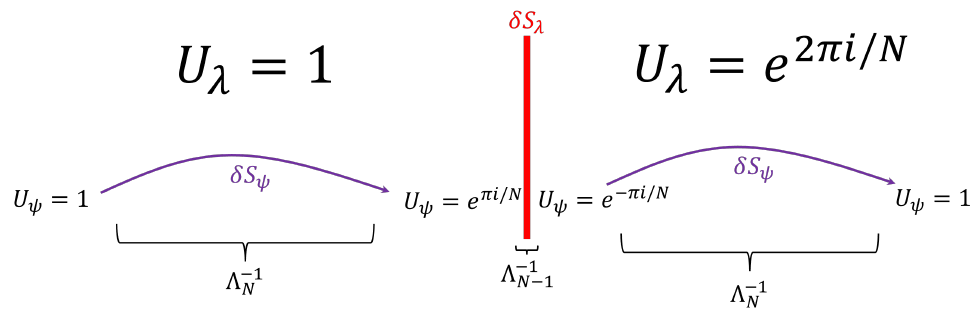
Figure 2 . An illustration of a domain wall configuration that interpolates between the vacuum U λ = 1 , U ψ = 1 on the left to U λ = e 2 πi/N , U ψ = 1 on the right. Due to the scale separation Λ Λ , the DW is described as follows. The phase of U N − 1 (cid:29) N Λ − 1 from 0 to π/N . At this point there is a rapid jump (at length Λ − 1 N